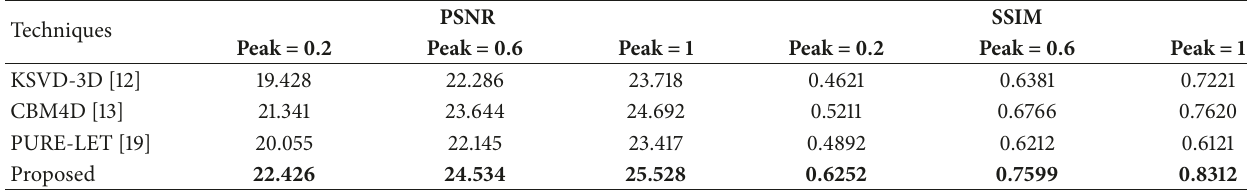
Table 3: Average PSNR (dB) and SSIM values of 311–325